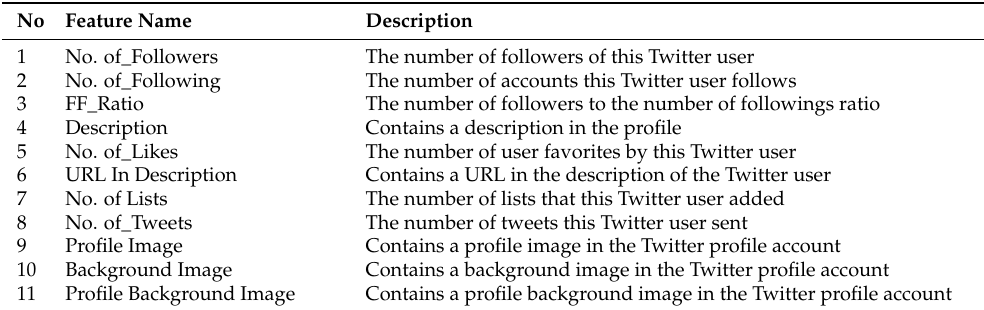
Table 3. Account-based features used in the